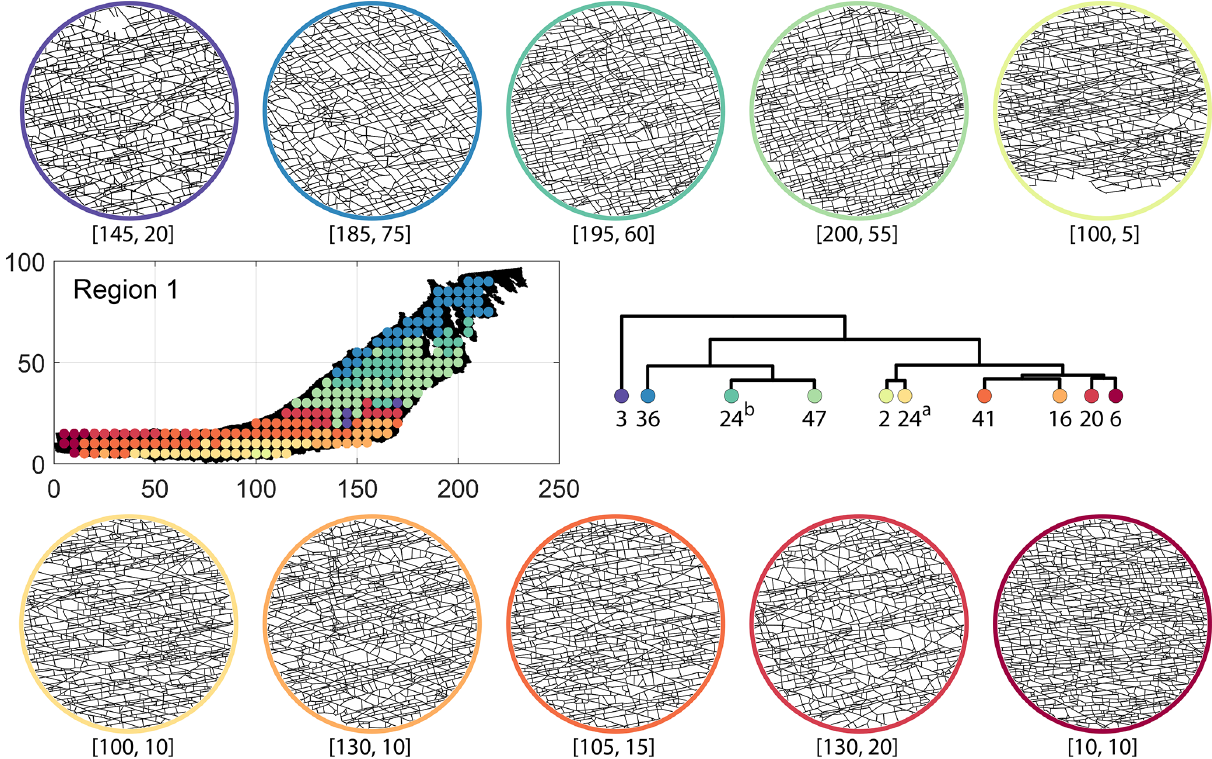
Figure C1. Circular subgraph samples depicting variation in fracturing style as identified in the 10 largest clusters by fingerprint distance in Region 1. Coordinates of circular sample centres are below each subgraph